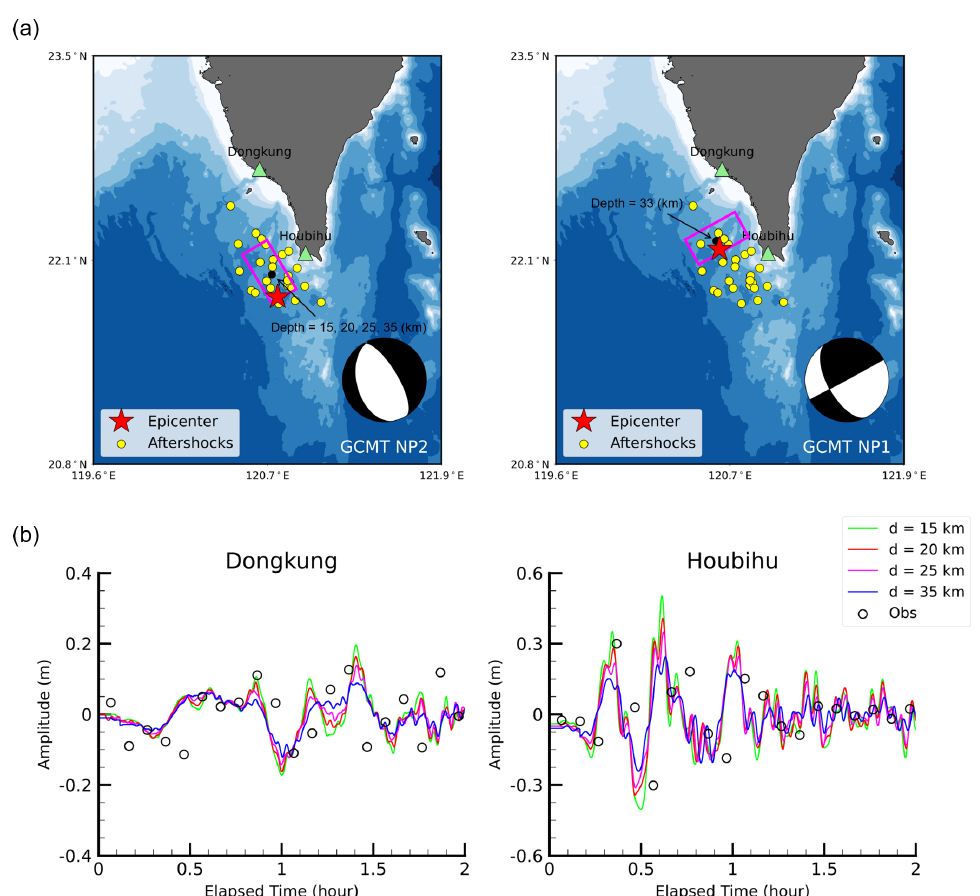
Figure 14. (a) Single fault models with fault dimensions (length × width) of 40km × 20km of the first earthquake using the GCMT NP2 nodal plane and the second earthquake using the GCMT NP1 nodal plane. The central fault depths of the single fault models for the first earthquake are set as 15, 20, 25, and 35km, and the central fault depth is fixed at 33km for the single fault models of the second earthquake for the tsunami sensitivity test. (b) Observed and simulated tsunami waveforms at the Dongkung and Houbihu stations using single fault models with the different central fault depths of the first earthquake.